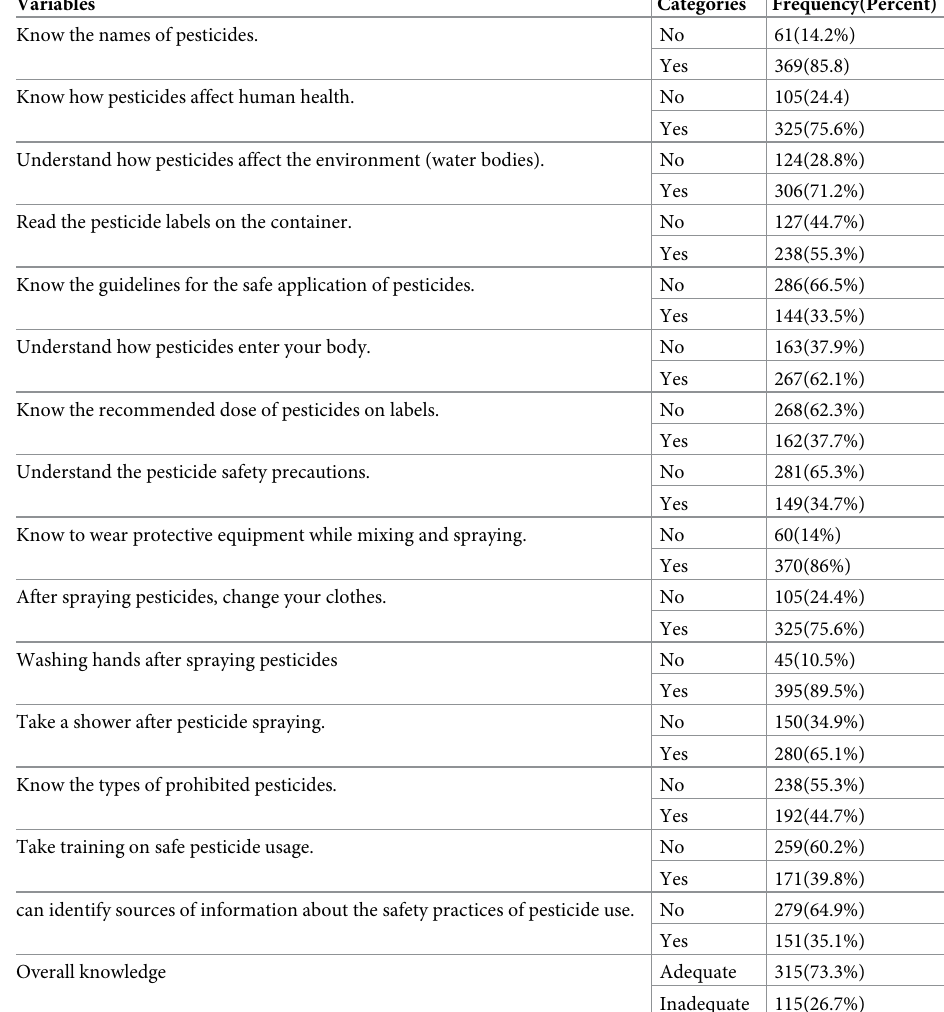
Table 2. Knowledge based factors on pesticides use safety practice in Fogera district farmers of wetland area, Northwest Ethiopia.